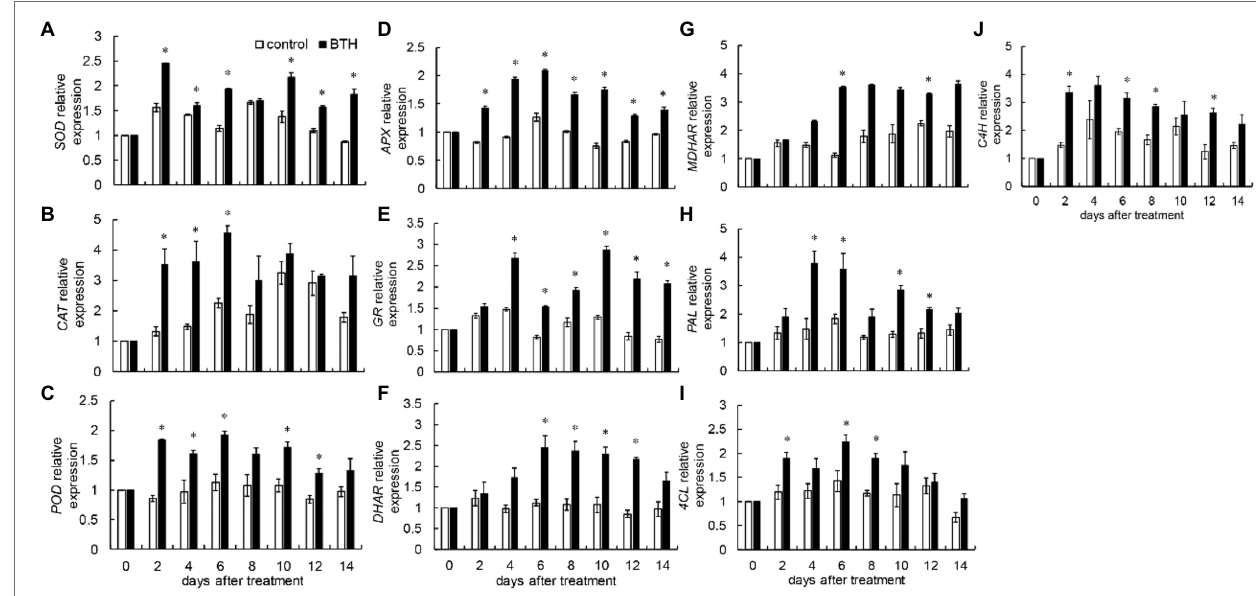
FIGURE 5 | Effects of BTH treatment on the expression of RrSOD (A) , RrCAT (B) , RrPOD (C) , RrAPX (D) , RrGR (E) , RrDHAR (F) , RrMDHAR (G) , RrPAL (H) , Rr4CL (I) , and RrC4H (J) in R. roxburghii fruit during low temperature storage. The significant differences at a level of 0.05 by LSD between the control and BTH-treated fruit are indicated by asterisks (*). Vertical bars represent the standard errors of the means